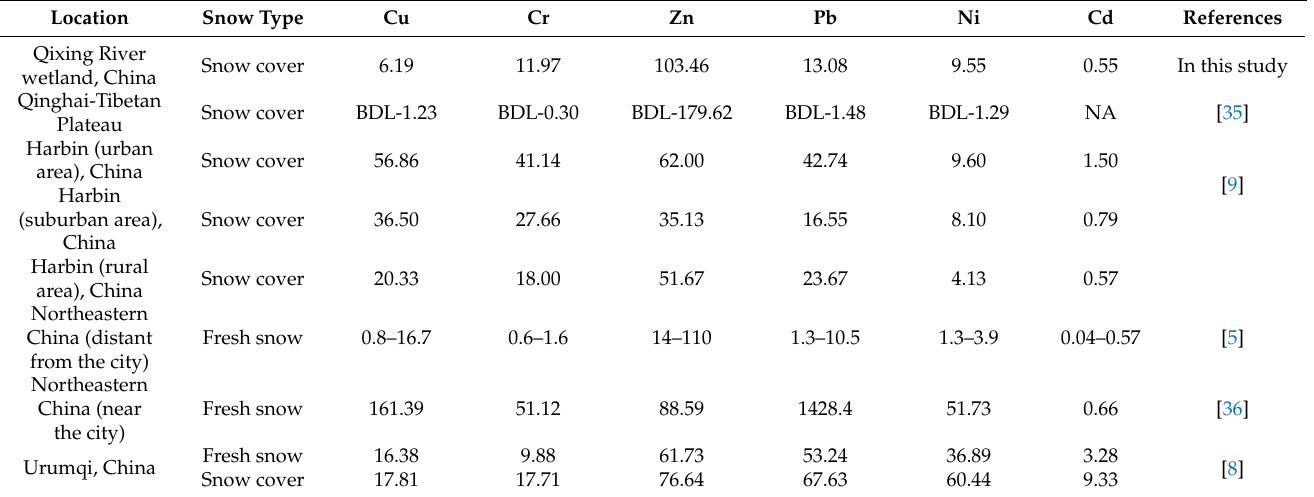
Table 1. Comparison of heavy metals in snow ( µ g L − 1